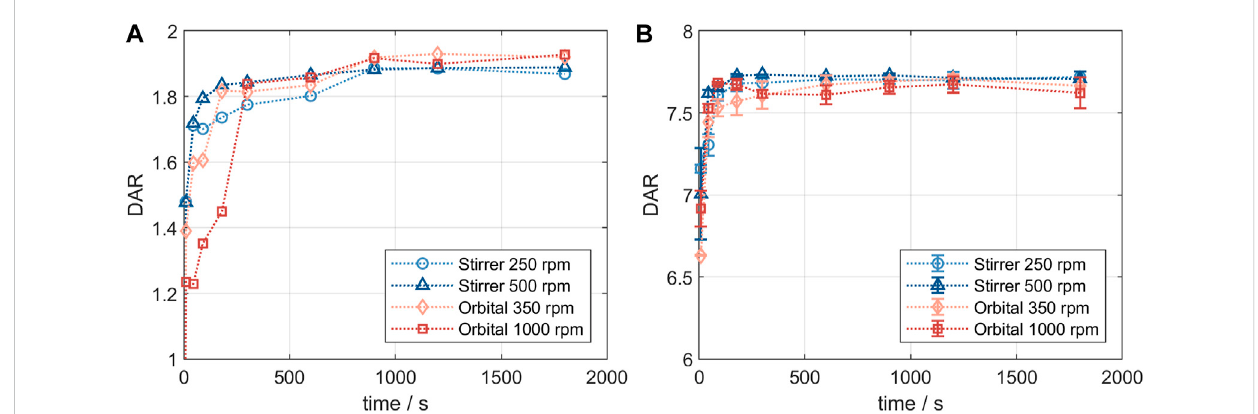
FIGURE 1 Comparison of the RP-UHPLC determined DAR conjugation kinetics performed in small-scale reaction tubes with different mixing systems and speeds. (A) ADC1 at a concentration of 10 mg/mL conjugated with 5x molar payload excess and (B) ADC2 at a concentration of 1.5 mg/mL conjugated with 11x molar payload excess. Runs were performed in duplicates and error bars represent the standard deviations.